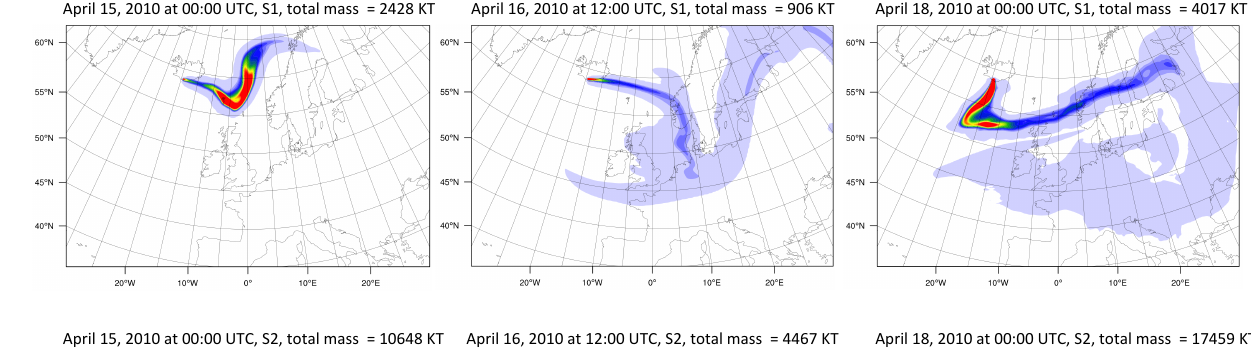
The radar heights indicate a continuous eruption starting with a plume height of 9 km on 14 April at 09:00